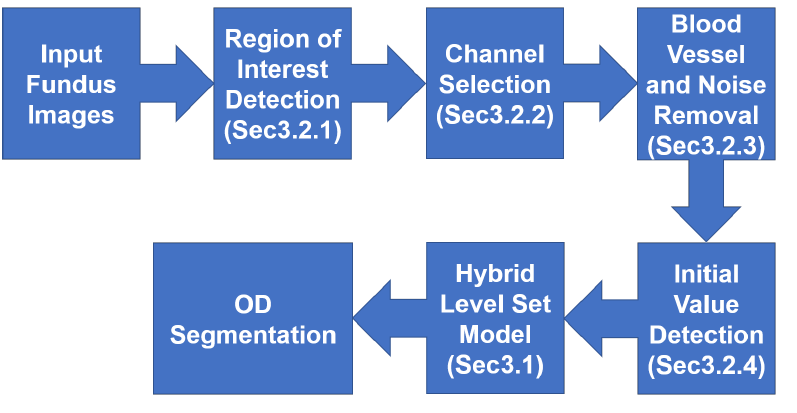
Figure 4. The flowchart of the